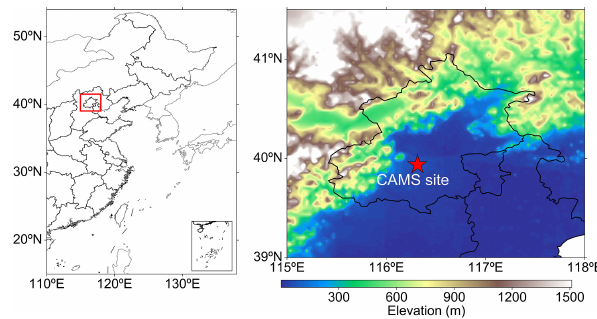
Figure 1. Location of the CAMS